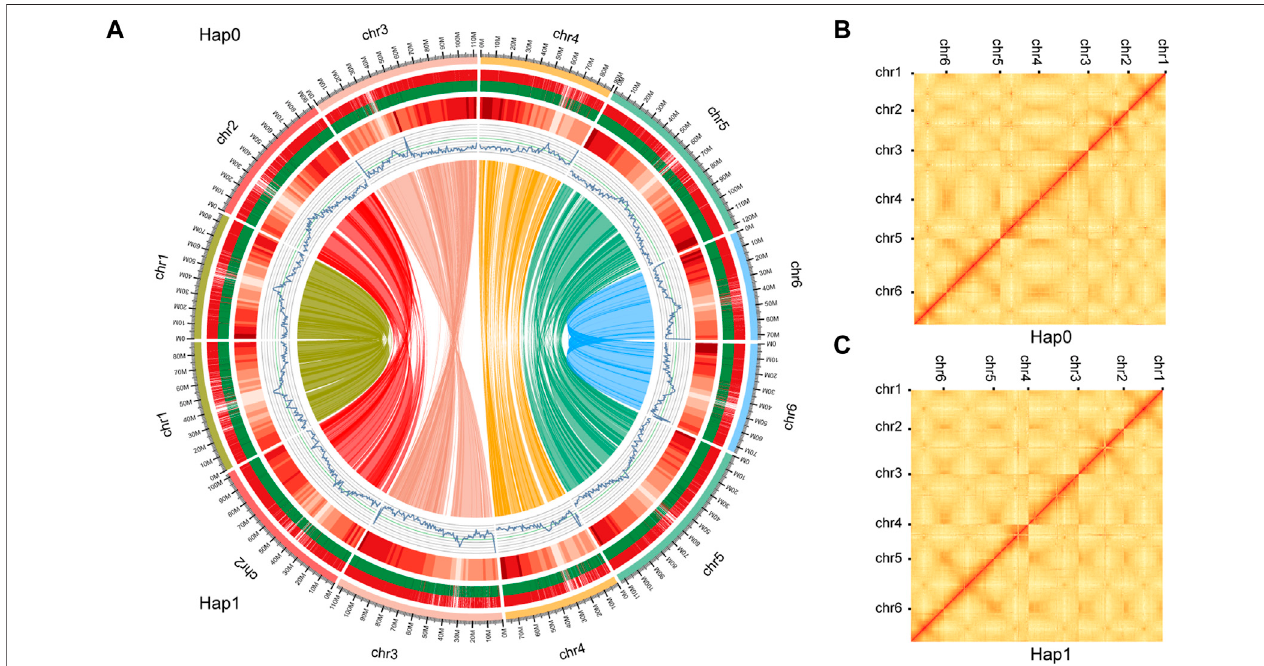
FIGURE 3 | Schematic representation of the genomic characteristics and Hi-C contact map of haplotypes 0 and 1. (A) Schematic representation of the genomic characteristicsofhaplotypes0and1.Fromtheouter-ring:Track1:the6pseudochromosomescomprisinghaplotypes0and1.genome;Track2:Protein-codinggenes presentineachofthechromosomes.Longandshortbarsrepresentgenesontheforwardandreversestrands,respectively;Track3:Thedistributionofthegenedensity using 1-Mb sliding windows. Higher densities are shown in darker red. Track 4: The distribution of the GC content. Track 5: The distribution of the repeat density using 1-Mbslidingwindows. Track6:Genesynteny betweenhaplotype 0and1assemblieswasanalyzed usingMCscanX.TheHi-Ccontactmap ofthehaplotype0 (B) and haplotype 1 (C) genome. The color bar shows the contact density from white (low) to red (high).